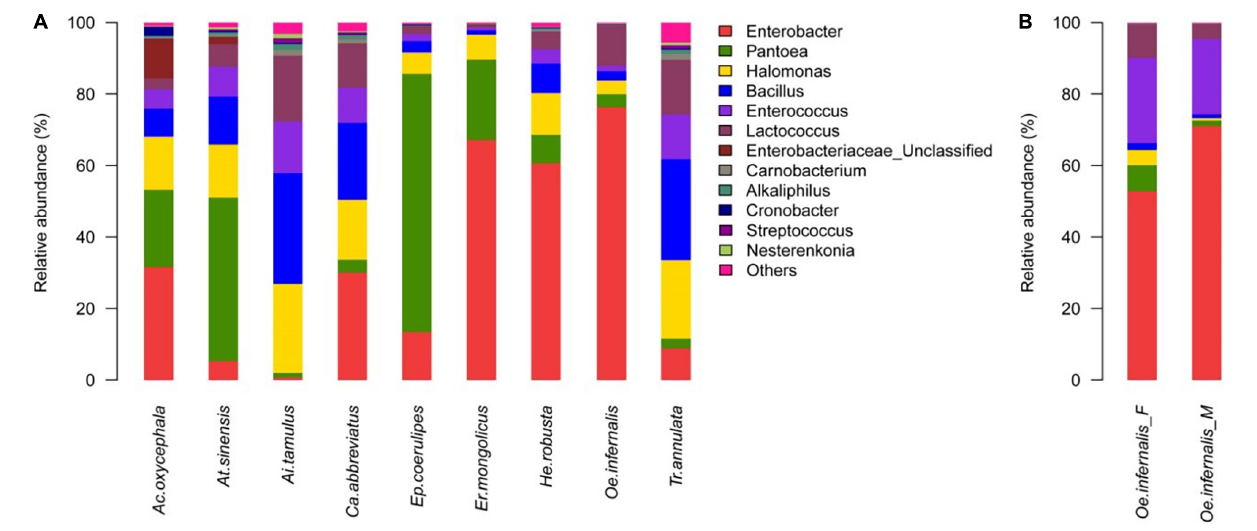
FIGURE 1 | Genus-Level Gut Bacteria Composition of Grasshoppers. (A) Relative contribution of the gut bacteria in Ac. oxycephala , At. sinensis , Ai. tamulus , Ca. abbreviatus, Ep. coerulipes , Er. mongolicus , He. robusta , Oe. infernalis , and Tr. annulata . (B) Relative contribution of the gut microbiota in fore-gut and mid-gut of Oe. infernalis